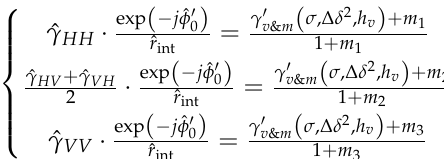
) (cid:10)D (cid:9) , K LMN